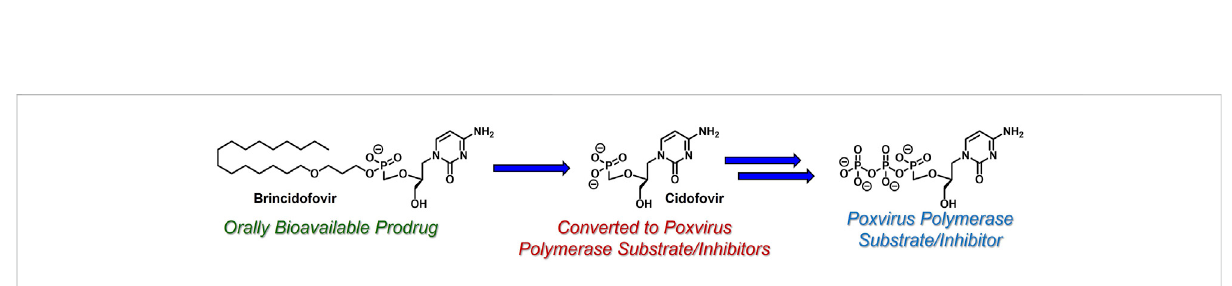
FIGURE 5 Acyclic nucleoside phosphonate cidofovir and its lipid-based prodrug brincidofovir, which can be administered orally to treat human poxvirus (e.g., smallpox and monkeypox